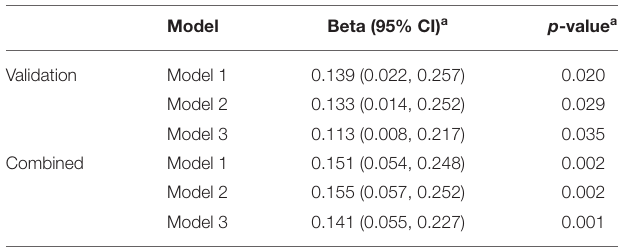
TABLE 3 | rs13019803 associated with sST2 concentrations in AD patients in the discovery stage.